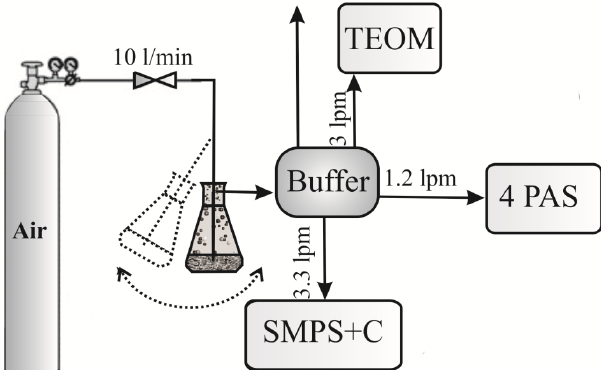
Figure 1. Schematic diagram of the experimental set-up (the ves- sel with dotted contour line and the arrow indicates that it is being